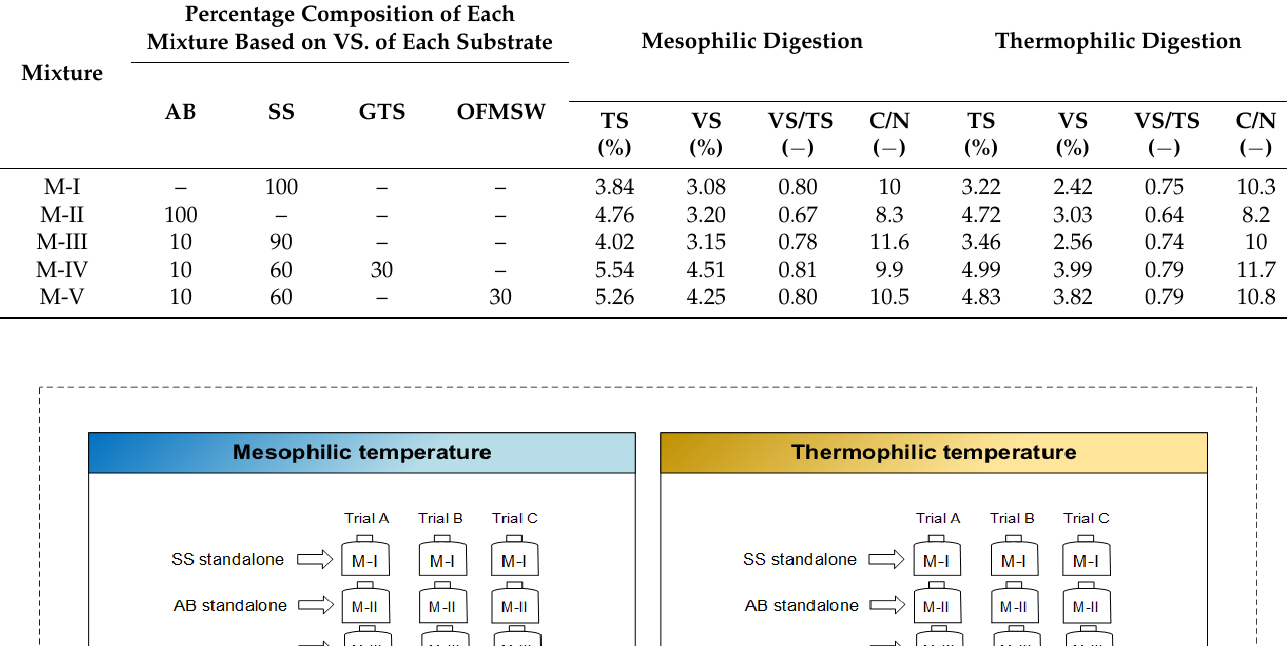
Table 2. Characteristics appertaining to organic composition of the analysed mixtures.